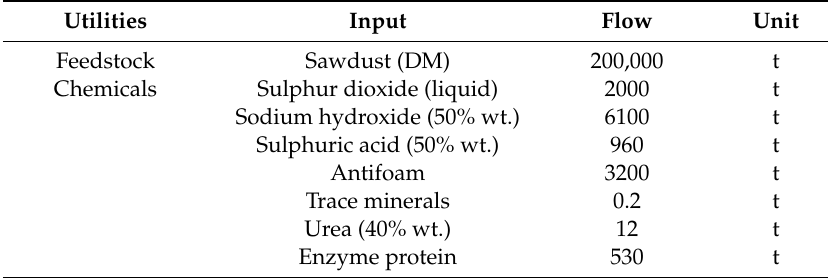
Table A1. Detailed description of material input per year based on data from [16–18,27].